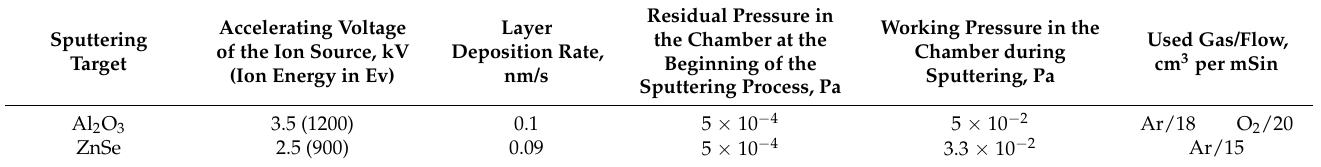
Table 1. Deposition parameters of the chosen